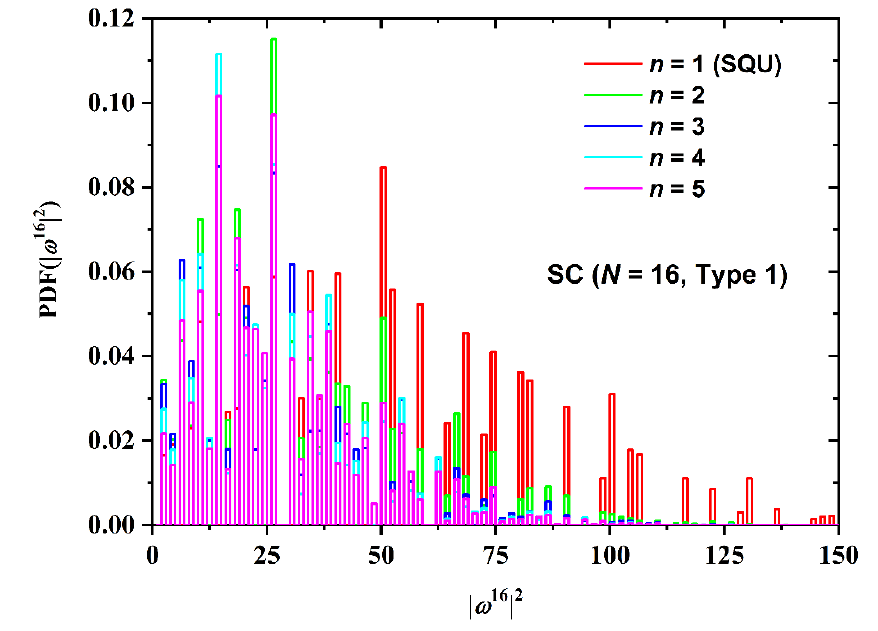
Figure 12. Probability distribution function (PDF) of the square end-to-end distance for the SC restricted lattice for SAWs of fixed length ( N = 16) and point of origin (Type 1). Different curves correspond to differ number of layers between the confining plates, n . The case of n = 1 corresponds to the 2-D square lattice (SQU).